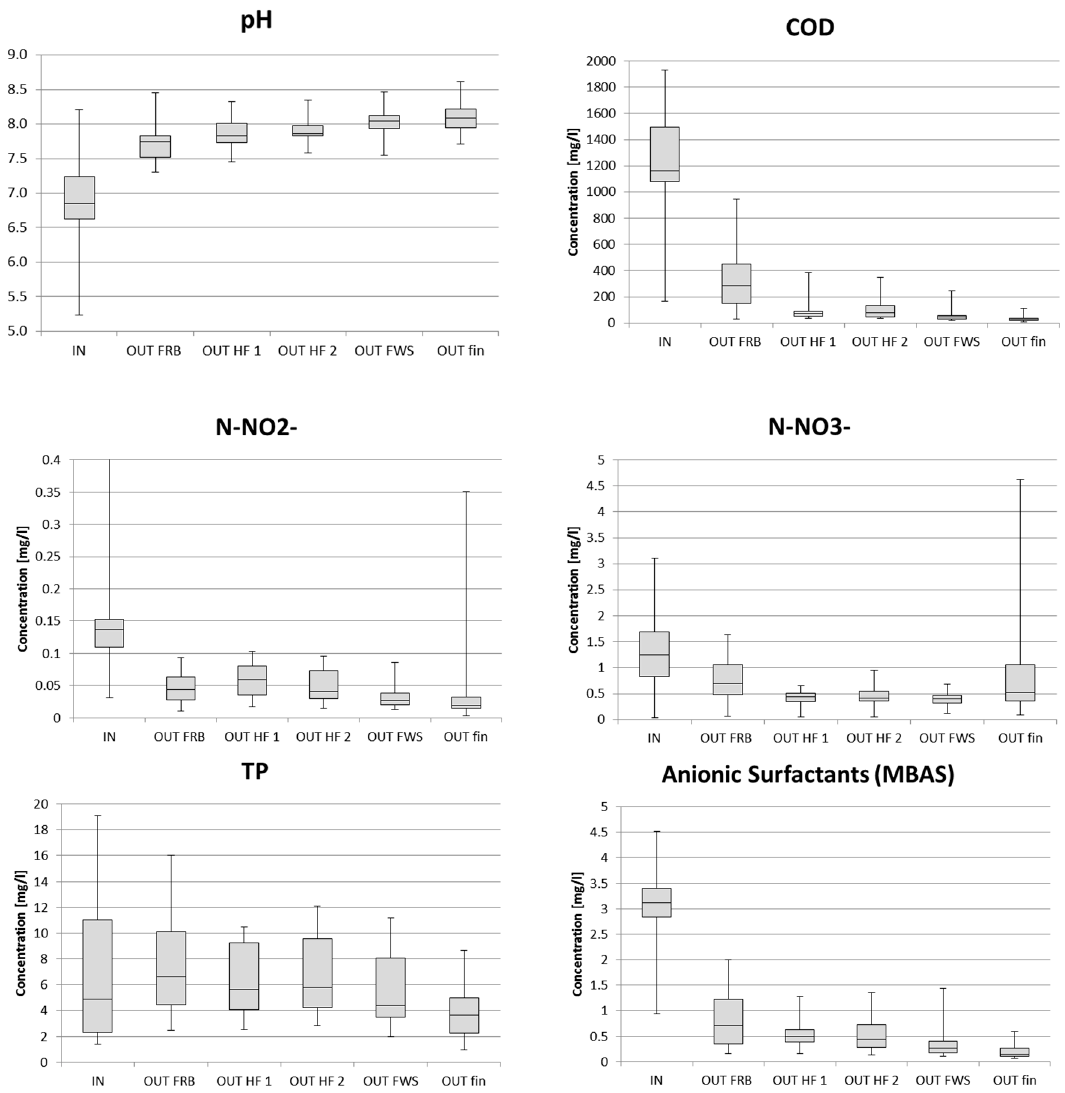
Figure 3. Box-Whisker plots for pH, COD, N-NO2-, N-NO3-, TP, and anionic surfactants (MBAS) at the different stages of the CW of Cecchi winery: influent (IN); effluent from the 1st stage French Reed Bed (FRB) beds (OUT FRB); effluent from the 2nd stage refurbished HF bed (out HF 1); effluent from the 2nd stage HF beds built during the 2009 upgrade (OUT HF 2); effluent from the 3rd stage FWS bed (OUT FWS); effluent from the official effluent sampling point, after the optional sand filter (OUT fin). Data from 19 January 2017 to 14 June 2019. Table 2. Statistical analysis of pollutant concentrations of wastewater treated by the CW of Cecchi winery at the different stages of the CW of Cecchi winery: influent (IN); effluent from the 1st stage FRB beds (OUT FRB); effluent from the 2nd stage refurbished HF bed (out HF 1); effluent from the 2nd stage HF beds built during the 2009 upgrade (OUT HF 2); effluent from the 3rd stage FWS bed (OUT FWS); effluent from the official effluent sampling point, after the optional sand filter (OUT fin). Data from 19 January 2017 to 14 June 2019.